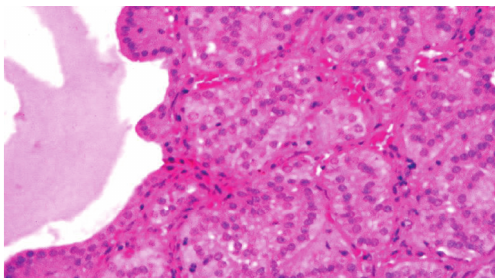
Figure8:Thyroidsectionsbigfollicularstructurewithafoldedwall, collapsed follicles, and pyknotic interstitial nucleus in ewes, H&E,